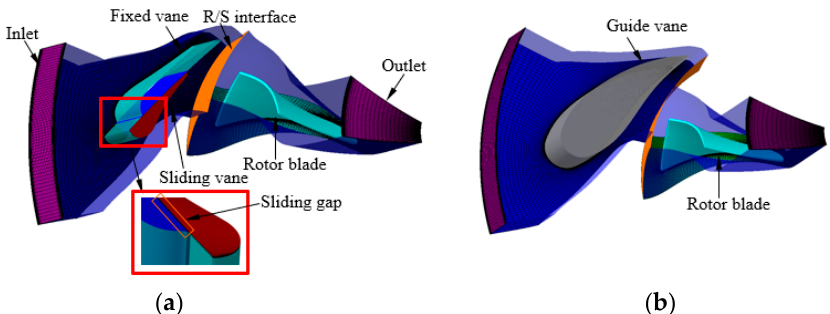
Figure 3. Single passage computation grid topology of the two models: ( a ) SSGV single passage calculation grid; ( b ) base model single passage calculation grid.